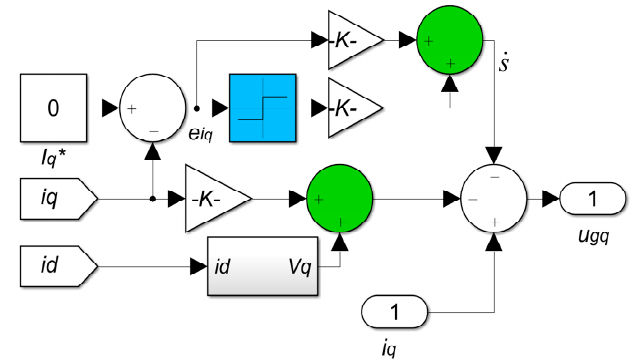
Figure 4. Simulation model of reactive component control structure controlled by SMVS.